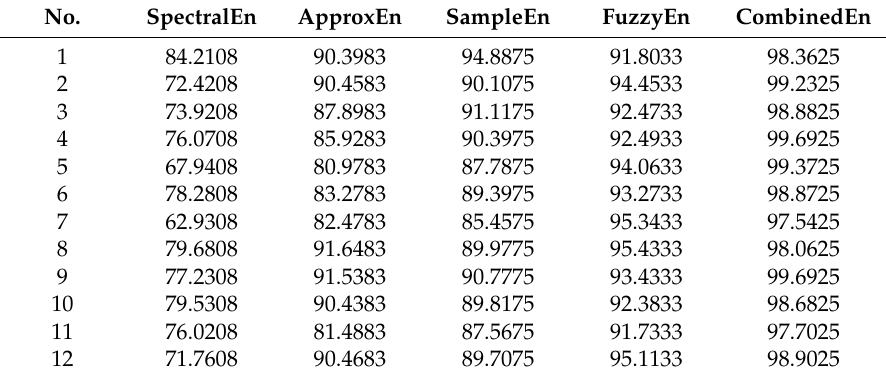
Table 2. The classification